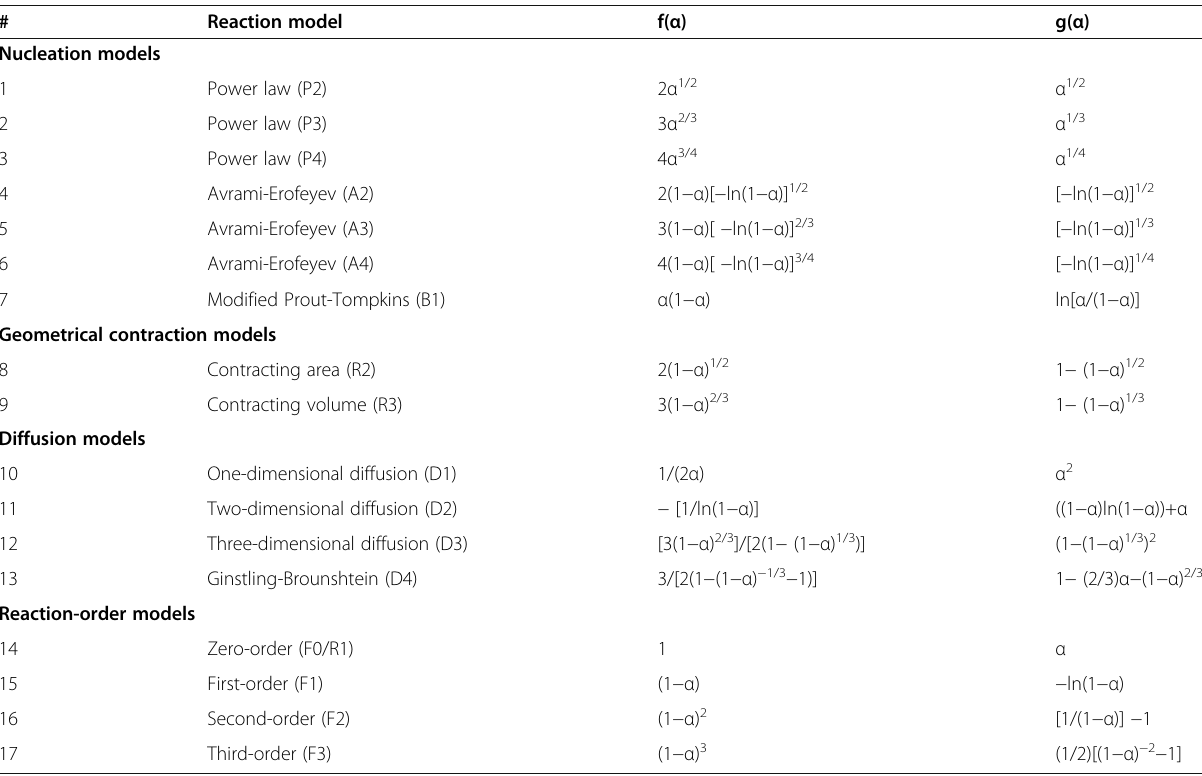
Table 1 Different reaction models used in the solid-state kinetics (Vyazovkin et al. 2011; Khawam and Flanagan 2006; Mili ć evi ć et al. 2017; Vyazovkin et al. 2014)